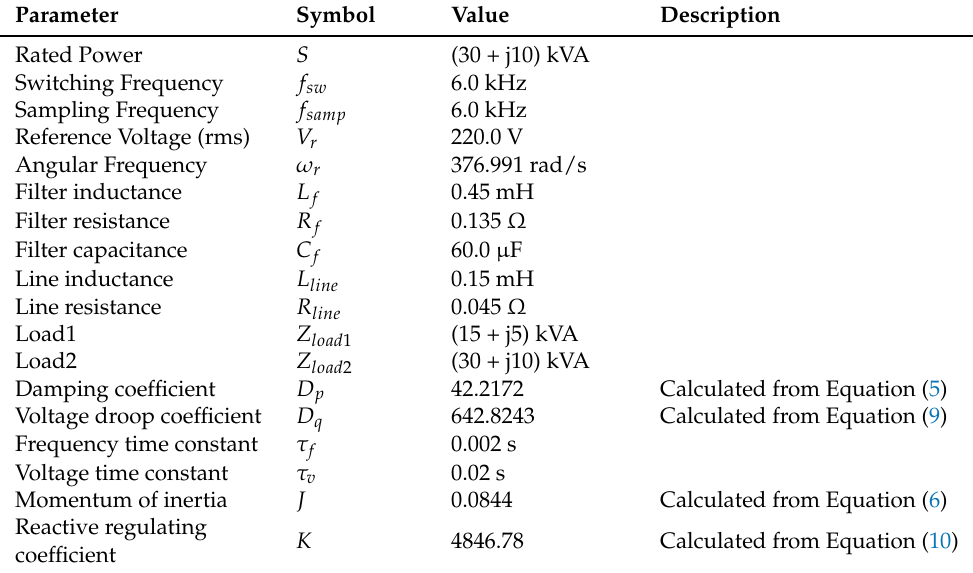
Table 1. Specific parameters of simulation.